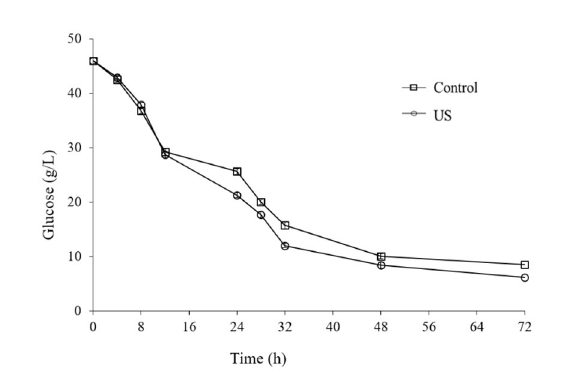
FIGURE3 Effect of ultrasound treatment at stage of 12th h of L. plantarum (ATCC 8014) growth on glucose consumption (g/L).